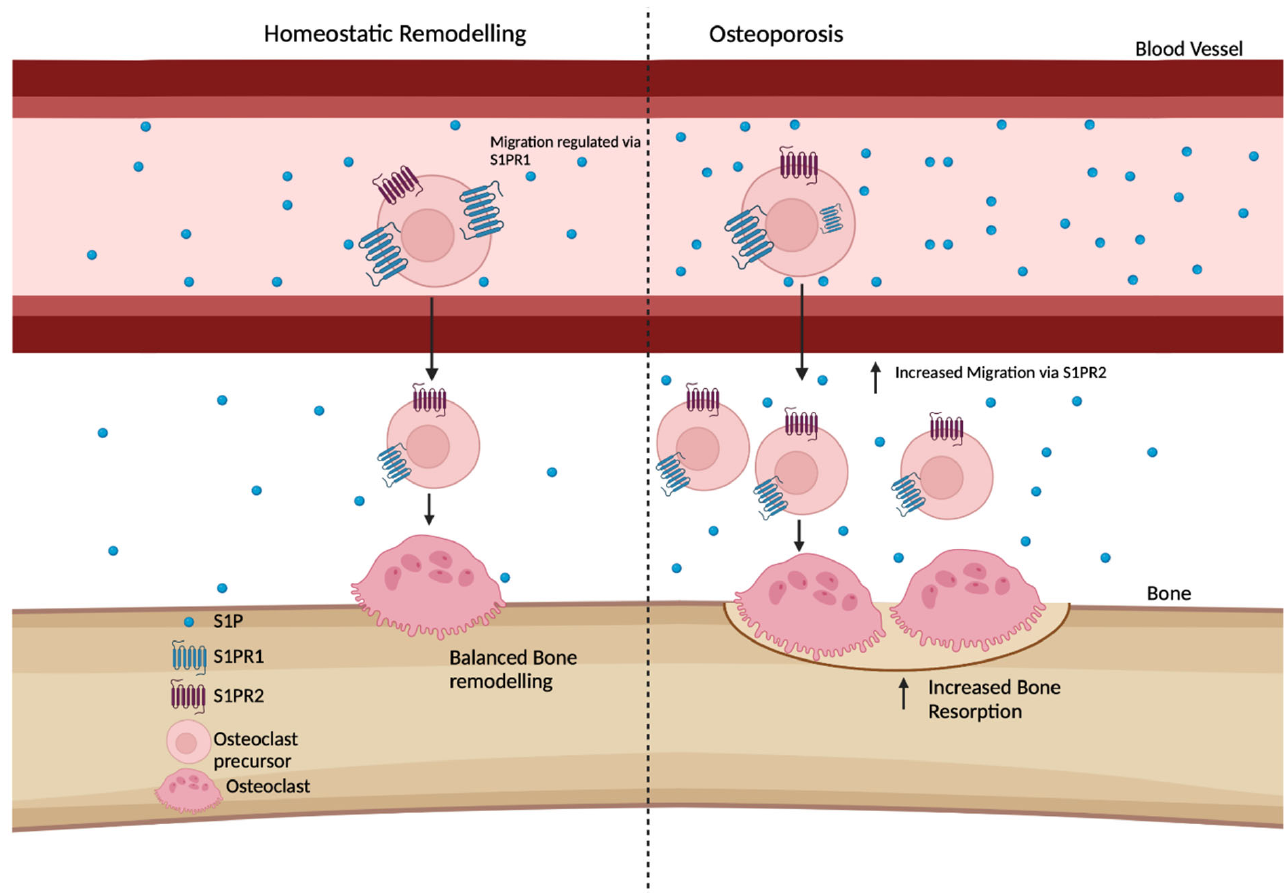
Figure 4. Osteoclast precursor migration is increased in osteoporosis due to increased plasma S1P. During typical homeostatic remodelling, it has been suggested that the S1P gradient allows for regulated migration of osteoclast precursors into the bone tissue via S1PR2 [35,36]. This is regulated via S1PR1, which opposes S1PR2, keeping some cells within circulation. Osteoporotic patients express increased plasma S1P [64–66]. This is thought to result in internalisation of the regulator receptor, S1PR1, causing increased migration of cells due to reduced opposition to S1PR2. Due to increased S1PR2 activity on osteoclast precursors, there are more migrating precursors that are thought to result in an increase in osteoclast numbers within the tissue, resulting in increased bone resorption. Created in